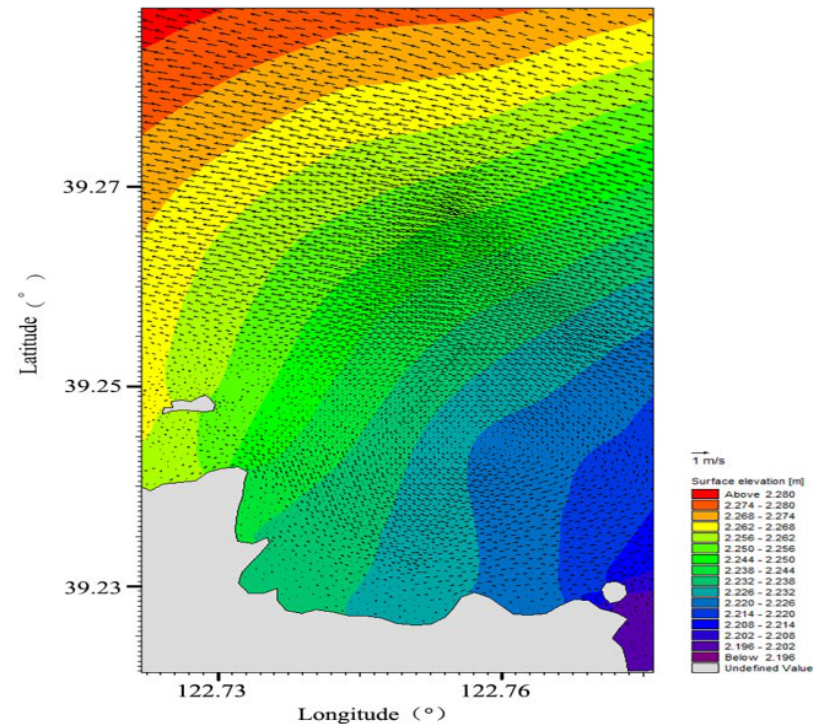
Figure 8. Flow field distribution at high tide.